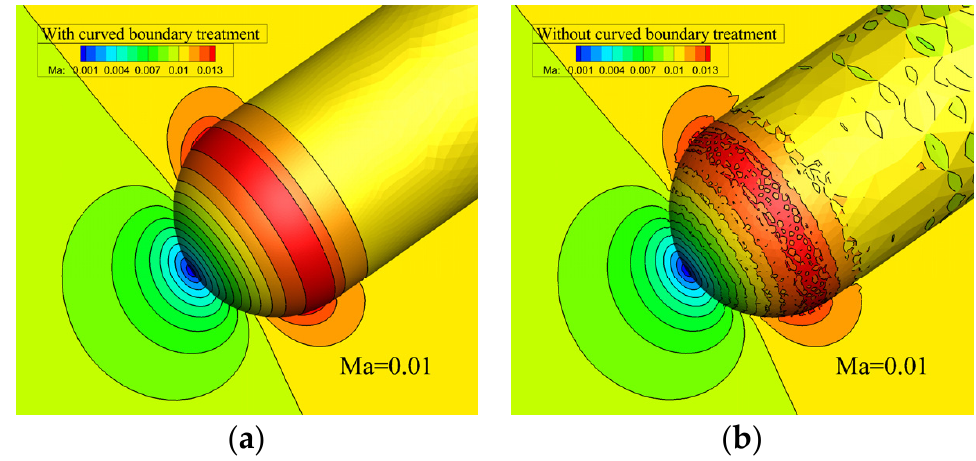
Figure 11. Computational mesh of the hemispherical headform.